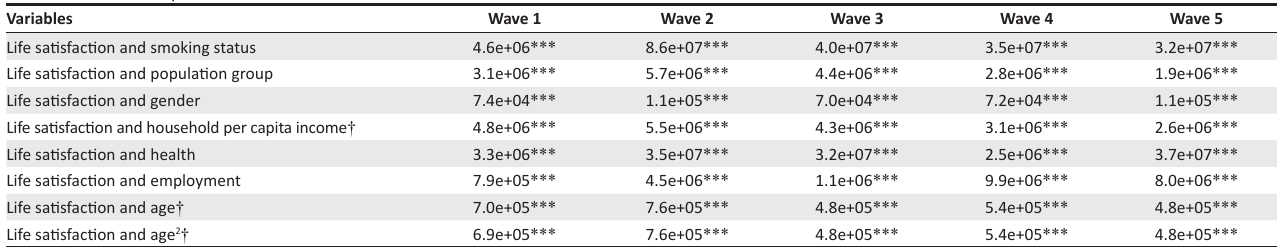
TABLE 2: Tests of independence.